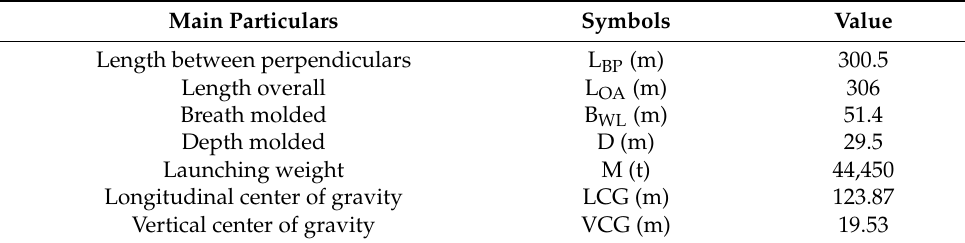
Table 2. The main parameters of 8500 TEU container ship model.